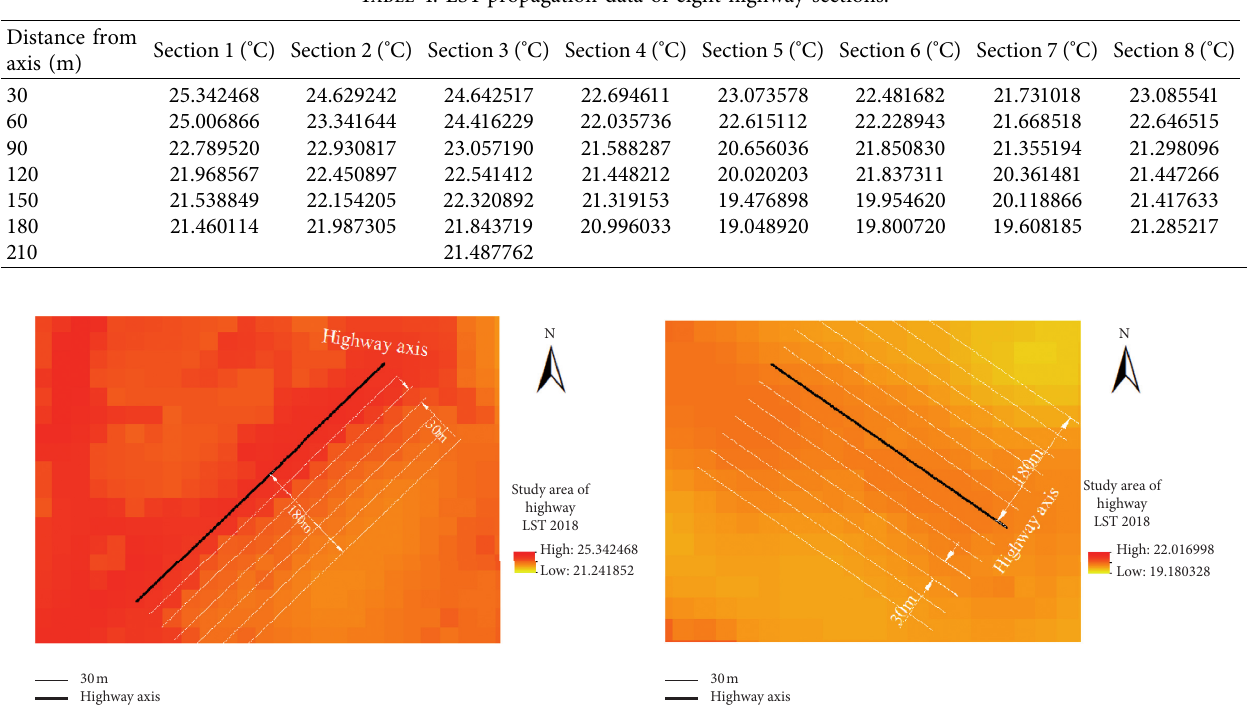
Table 4: LST propagation data of eight highway sections.